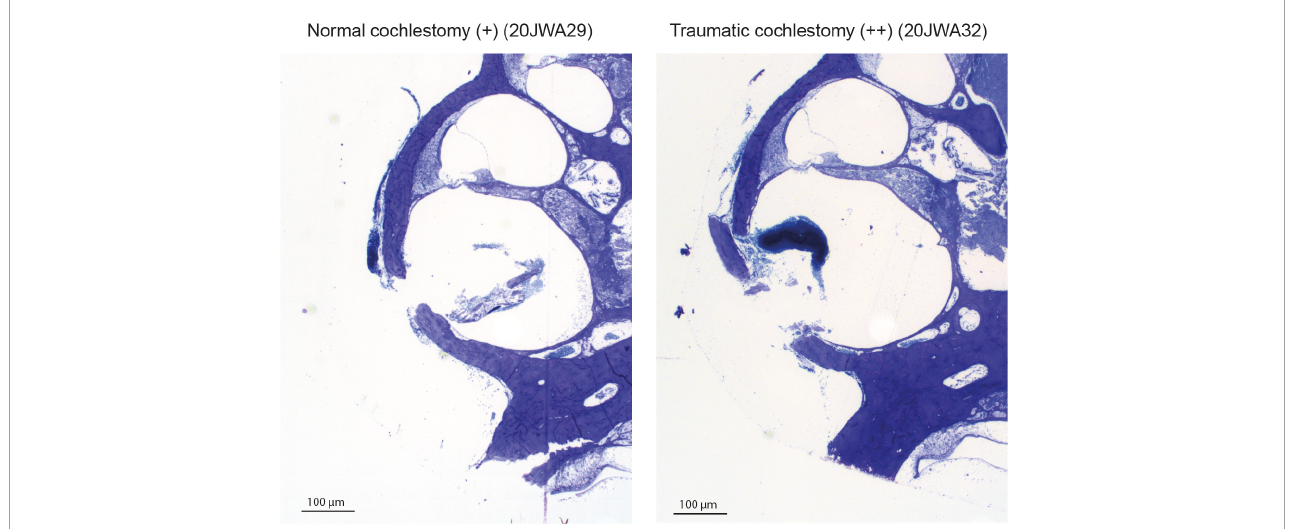
FIGURE2 Two examples of the cochleostomy site: 20JWA29 shows a normal cochleostomy site, with no additional fracture of the lateral wall besides the intended cochleostomy. 20JWA32 shows a traumatic cochleostomy with an additional fracture of the lateral wall, splintered bone, and red blood cells near the cochleostomy.